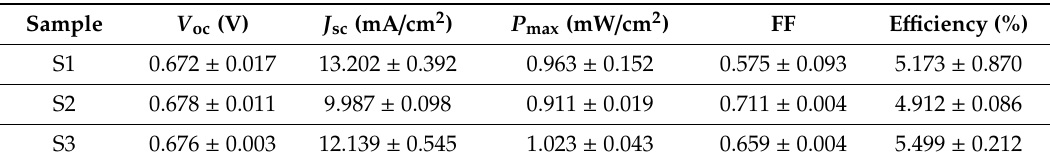
Table 2. A summary of average extracted J - V characteristics for dye-sensitized solar cell (DSSC) devices fabricated using S1, S2, and S3 samples.